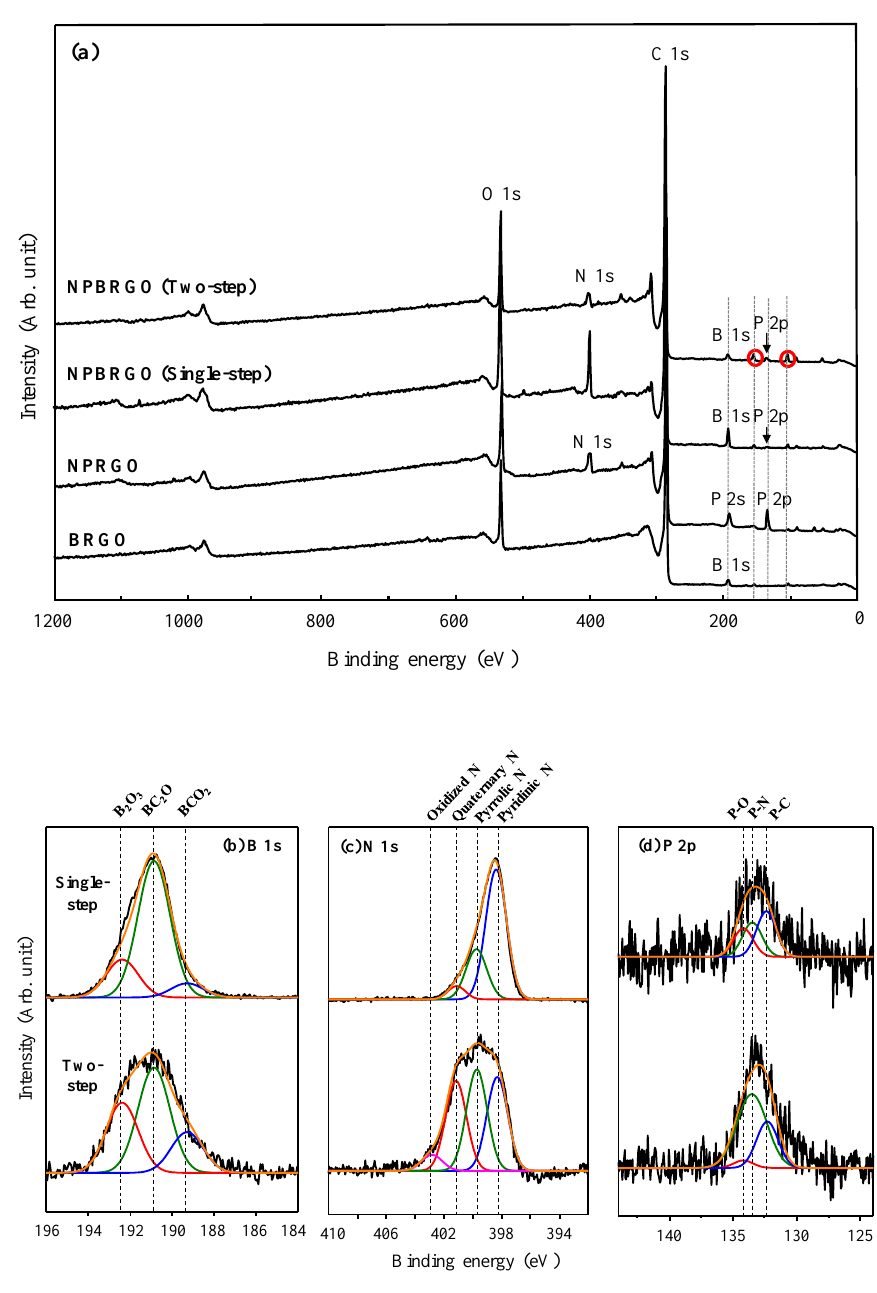
B 1s XPS spectra of NPBRGO (single-step) and NPBRGO (two-step) (Figure 2b–d). The B 1s spectra (Figure 2b) can be deconvoluted into three peaks at, 189.3, 190.8 and 192.4 eV, which are assigned to substitutional boron, BCO 2 , BC 2 O and B 2 O 3 , respectively [30]. The N 1s spectra (Figure 2c) consists of four peaks at 398.5, 399.8, 401.1 and 403.0 eV, which are assigned to pyridinic, pyrrolic, quaternary N and oxidized N, respectively [31,32]. The P 2p peak (Figure 2d) is deconvoluted into three peaks at 134.2, 132.4 and 133.5 eV, which can be assigned to P-O, P-N and P-C bonds, respectively [33]. The relative number of bonding configurations for ternary doped RGOs obtained using single-step and two-step methods are summarized in Table S1.